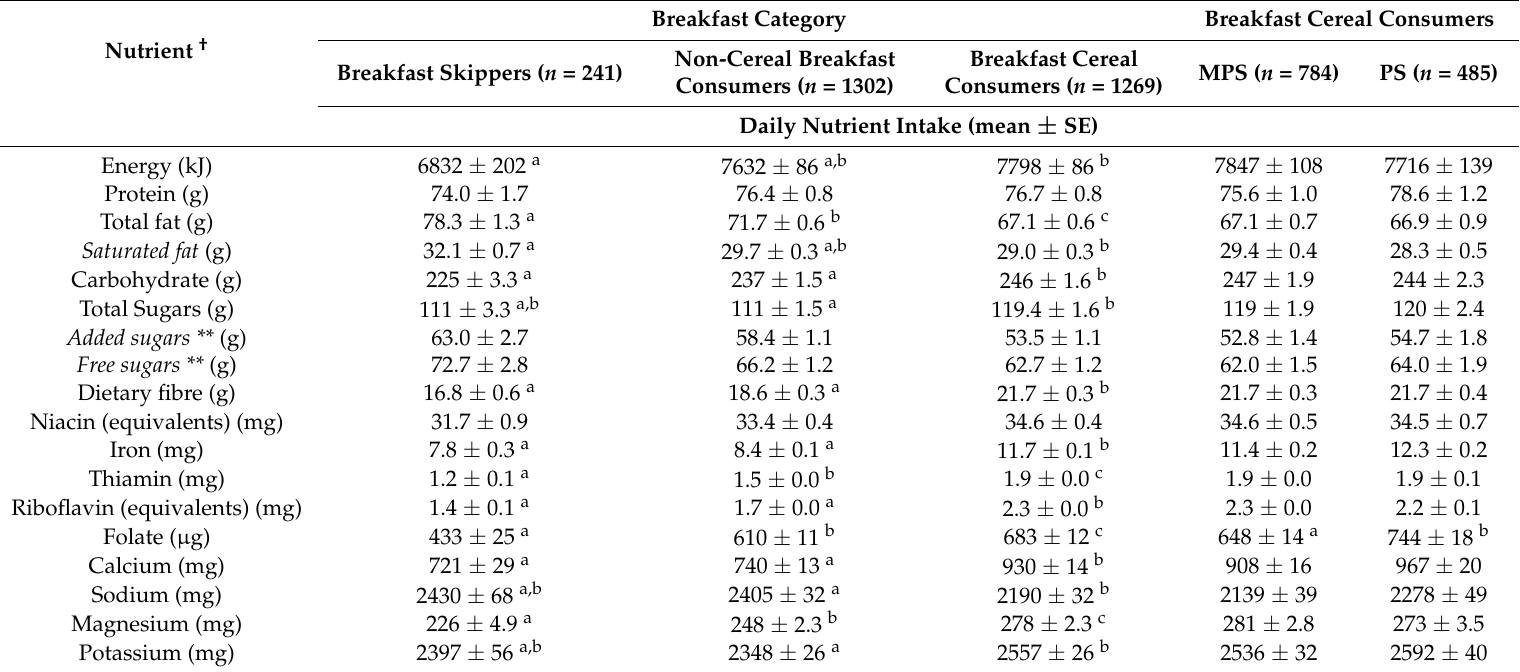
Table 3. Total daily energy and nutrient intakes by categories of breakfast consumers * and breakfast cereal type among 2–18-year-old based on the 2011–2012 National Nutrition and Physical Activity Survey ( n =